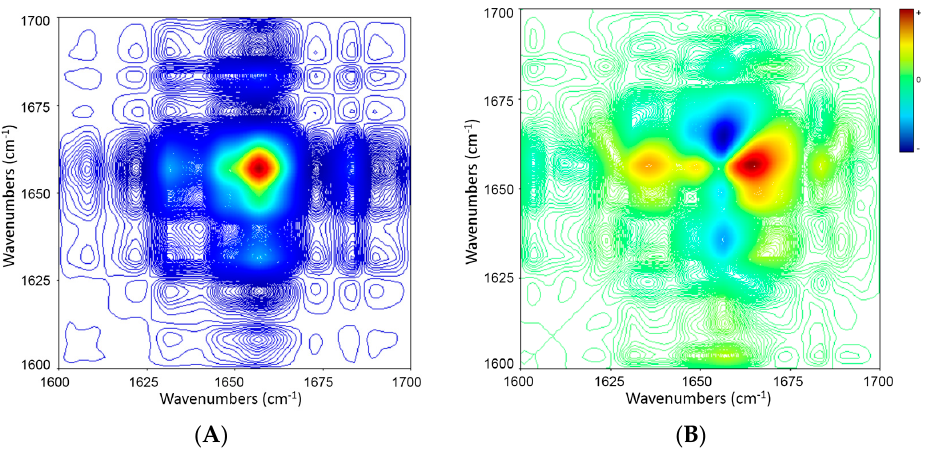
Figure 5. 2D IR synchronous ( A ) and asynchronous ( B ) maps of amide I bands of ICFs (5% w / v in D 2 O) during heating (5 → 70 °C, in increment of 5 °C). Red and blue represent positive and negative correlation peaks, respectively.